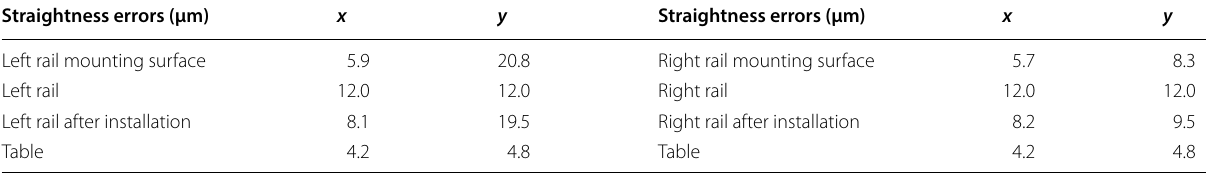
Table 6 Error transfer values for each mounting surface from bottom to top Straightness errors